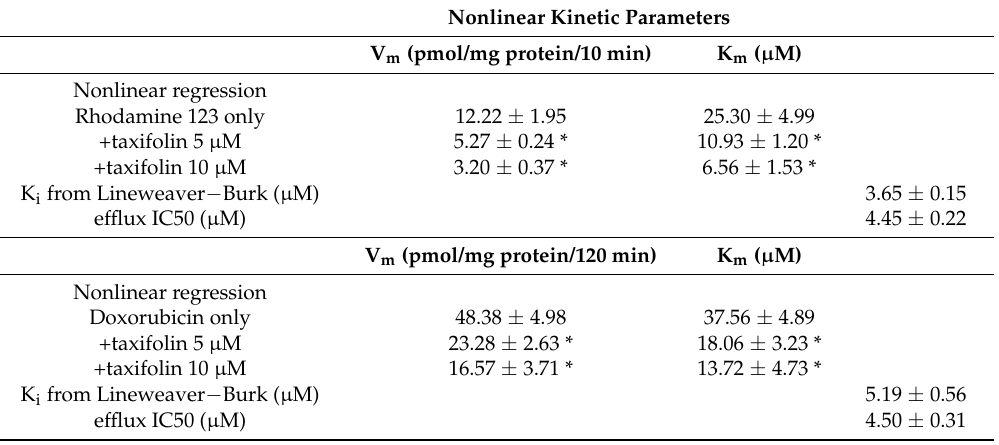
Table 1. The effects of taxifolin on human P-gp-mediated efflux of rhodamine123 and doxorubicin in ABCB1 /Flp-In TM -293